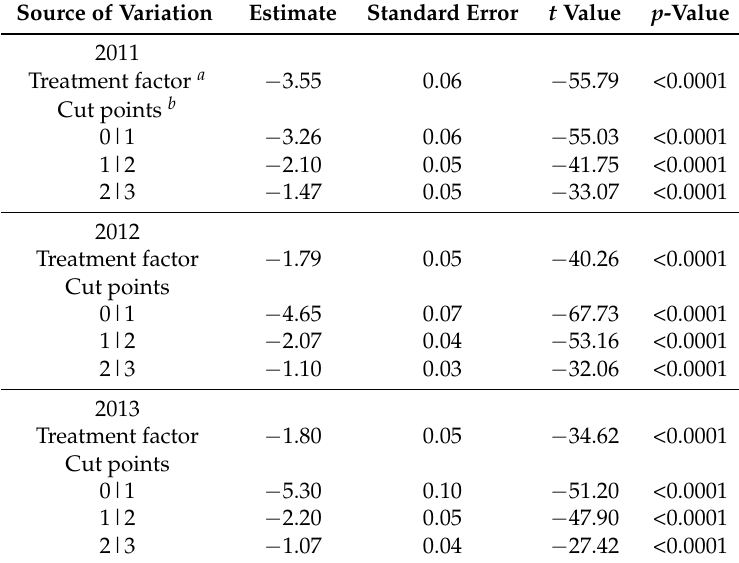
Table 2. Results obtained with the proportional odds logistic regression of greasy spot severity categories in experiment 1 on ‘Start Ruby’ grapefruit at Tambo, Panama from 2011 to 2013.